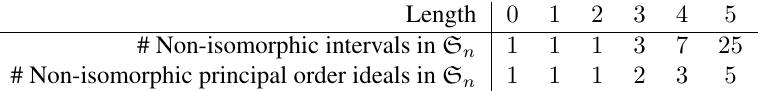
Tab. 1: The number of non-isomorphic intervals and principals order ideals of length at most 5 (as defined in Defini- tion 1.2) appearing in the Bruhat order of symmetric groups.